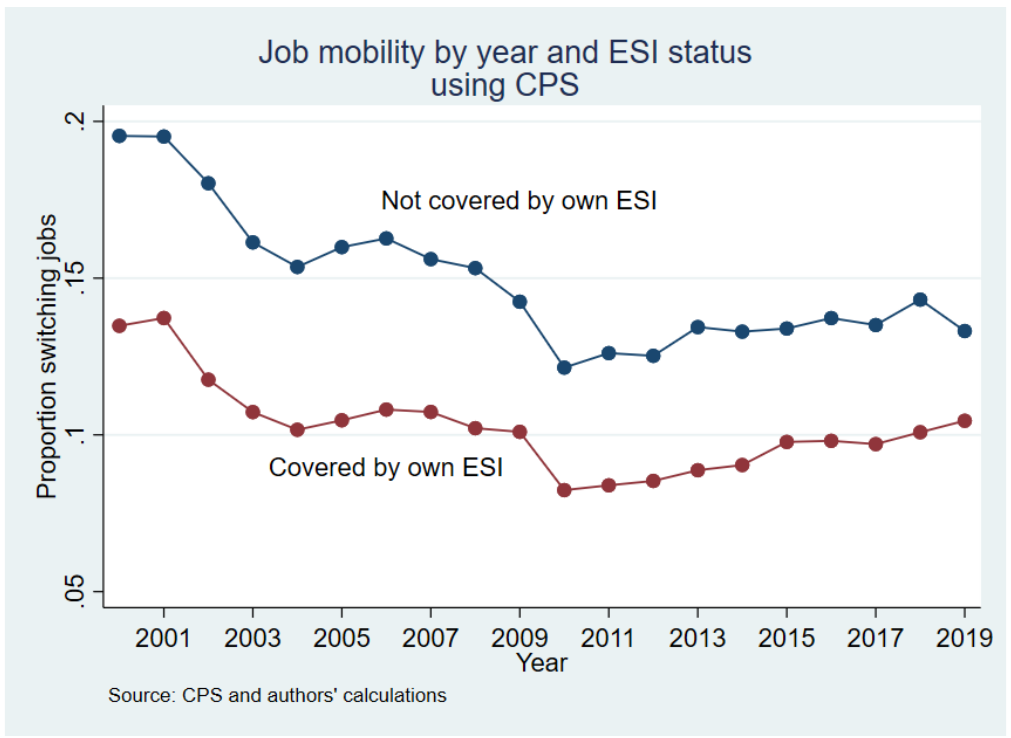
Figure 2. Trends in Job Mobility across ESI Status in the CPS.